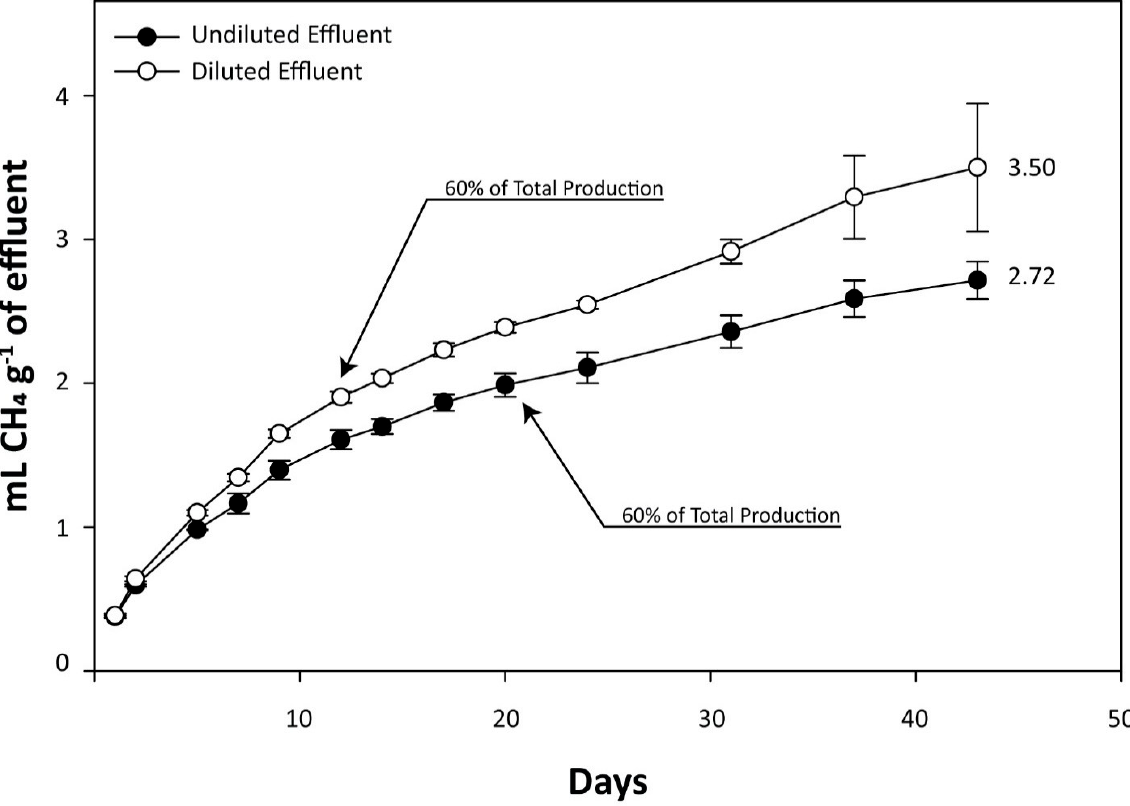
Figure 2. Accumulative methane production of diluted and undiluted effluent samples from the biogas plant.